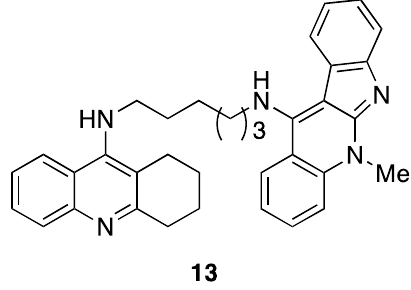
Figure 5. Structure of tacrine-neocryptolepine hybrids.